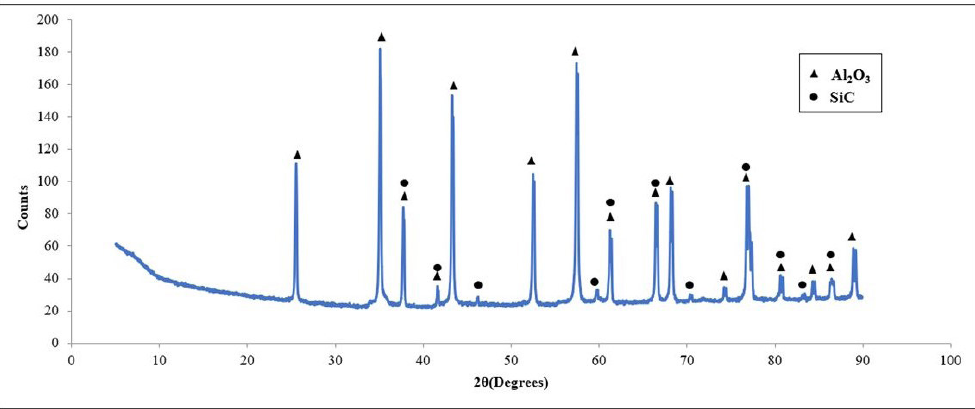
O -20 vol% SiC sintered at 1500°C showing only Al 2 3